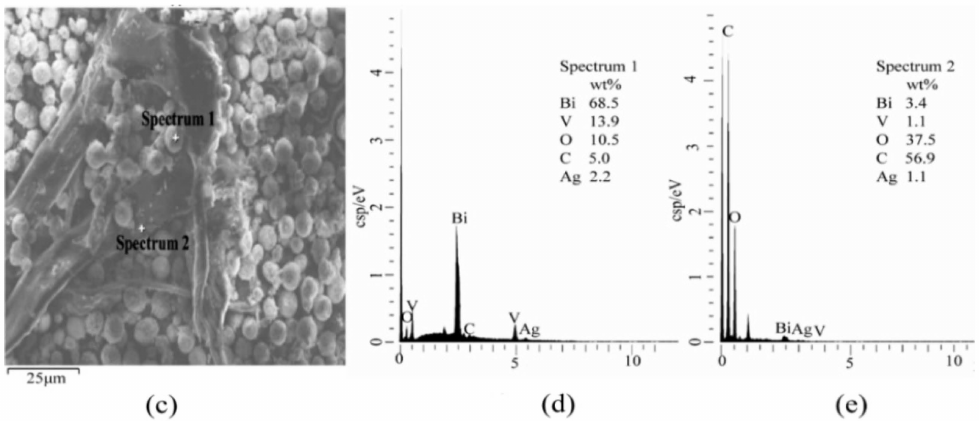
Figure 3. EDX spectrum of the AgGB-0.5 composite and the corresponding EDX elemental mapping results: ( a ) AgGB-0.5 composite; ( b ) BiVO 4 and Ag microspheres; ( c ) AgGB-0.5 composite; and ( d , e ) the corresponding EDX elemental mapping results of AgGB-0.5 composite.